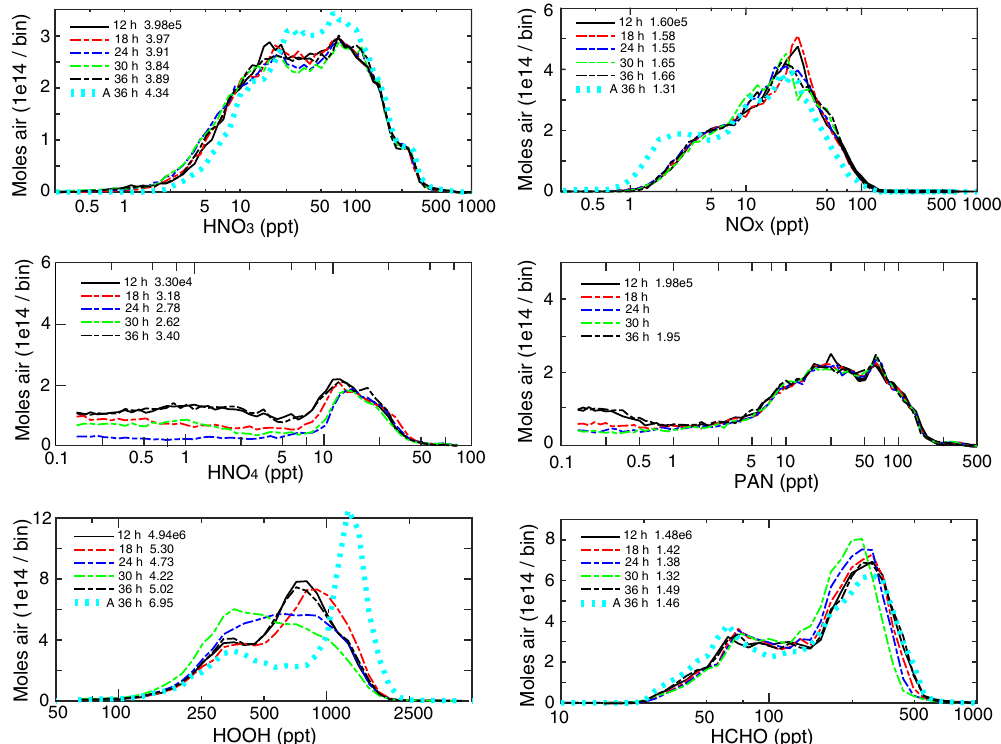
Figure 2. One-dimensional probability distributions for HNO 3 , NO x , HNO 4 , PAN, HOOH, and HCHO from the UCI-CTM. The domain sampled is the tropical Pacific: 20 ◦ S–20 ◦ N, 150–210 ◦ E, 0–12 ◦ km, on 16 August. The units are moles of air per log-scale bin (20 bins per factor of 10). The area under the curve in the log plot is the air mass of the domain, except for HNO 4 and PAN for which there are numerous observations below the cutoff at 0.1ppt. Five different times are shown for the C-run: local noon (12h), sunset (18h), midnight (24h), sunrise (30h), and the following noon (36h). Also shown is the A-run at noon (12h, same as C-run) and the following noon (A 36h). The numbers of moles of the species in the domain are given in the